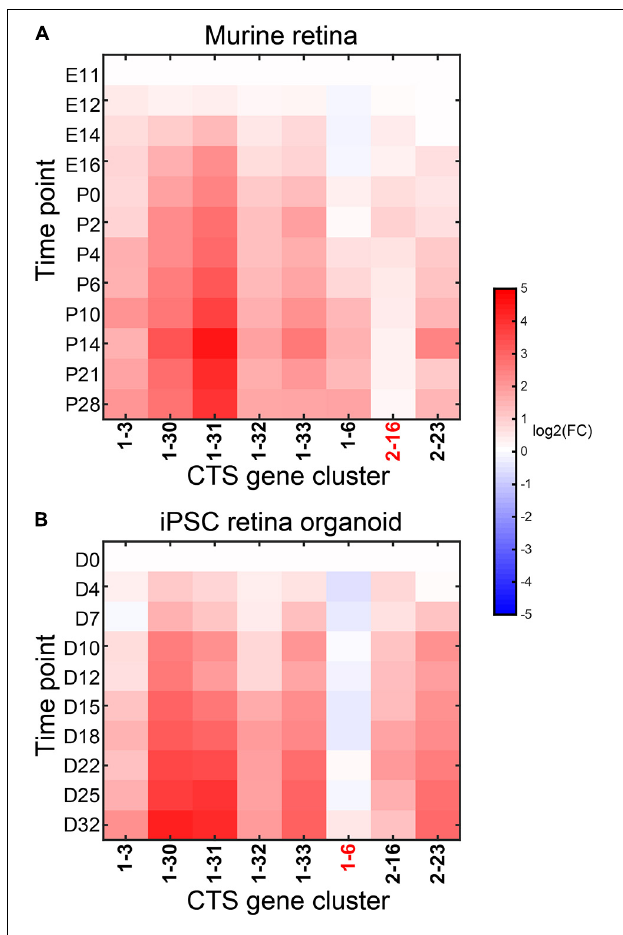
FIGURE 11 | Expression fold change of the significantly up-regulated gene clusters in the in vivo (A) and in vitro (B) developing mouse